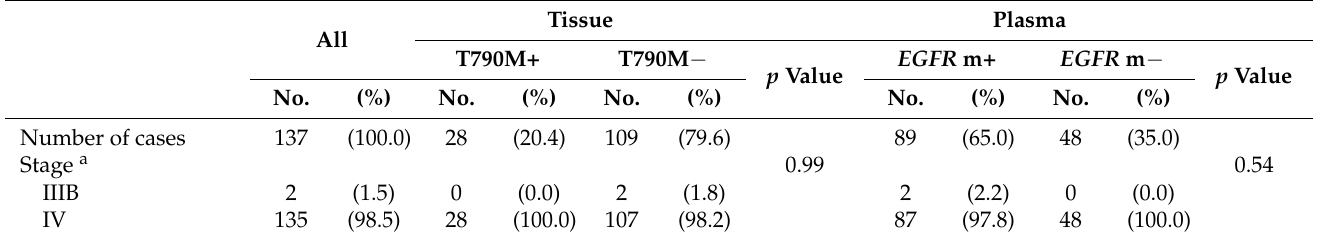
Table 3. Patient characteristics stratified by tissue EGFR T790M or plasma EGFR -activating mutation status at baseline (N =